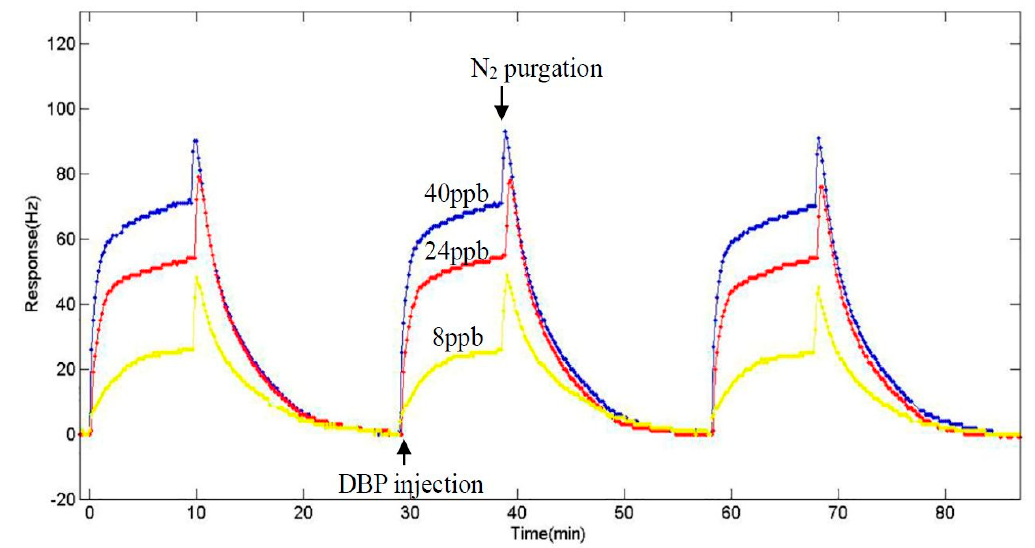
Figure 5. Response of the nano-Ni(OH) 2 -coated QCM sensor to 8, 24, and 40 ppb (from bottom to top) of DBP.